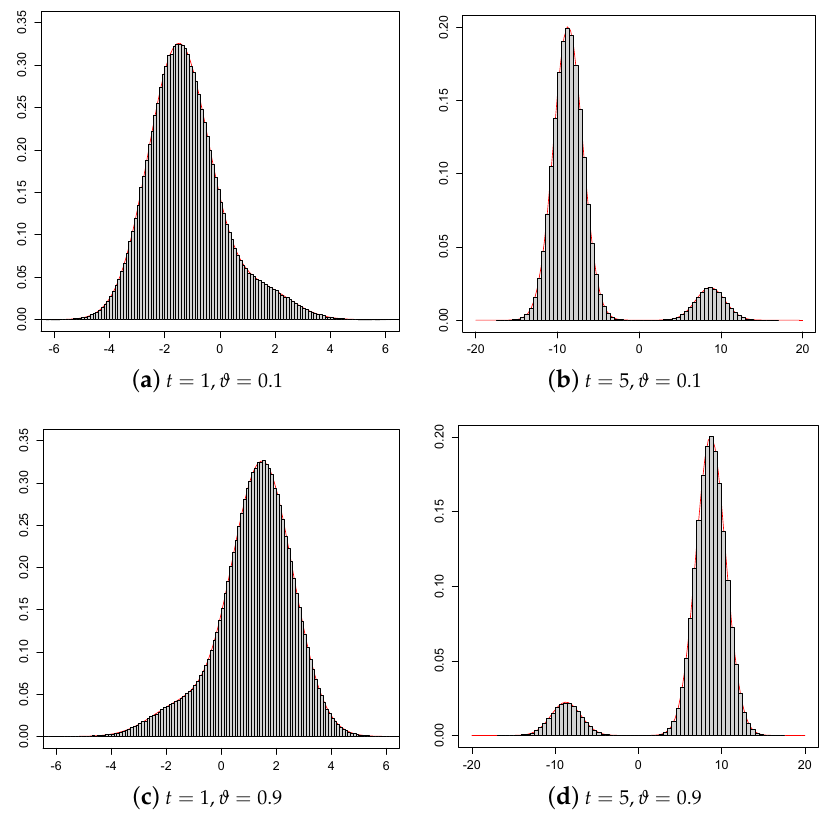
Figure 9. For the process Z ( t ) having infinitesimal moments (81), with ( y , τ ) = ( 0,0 ) and α = − 0.2, γ = 1.5, ν = 0.1, Q = 2, the transition pdf (64) as a function of x is superimposed over a histogram obtained via Algorithm 1 for different choices of t .